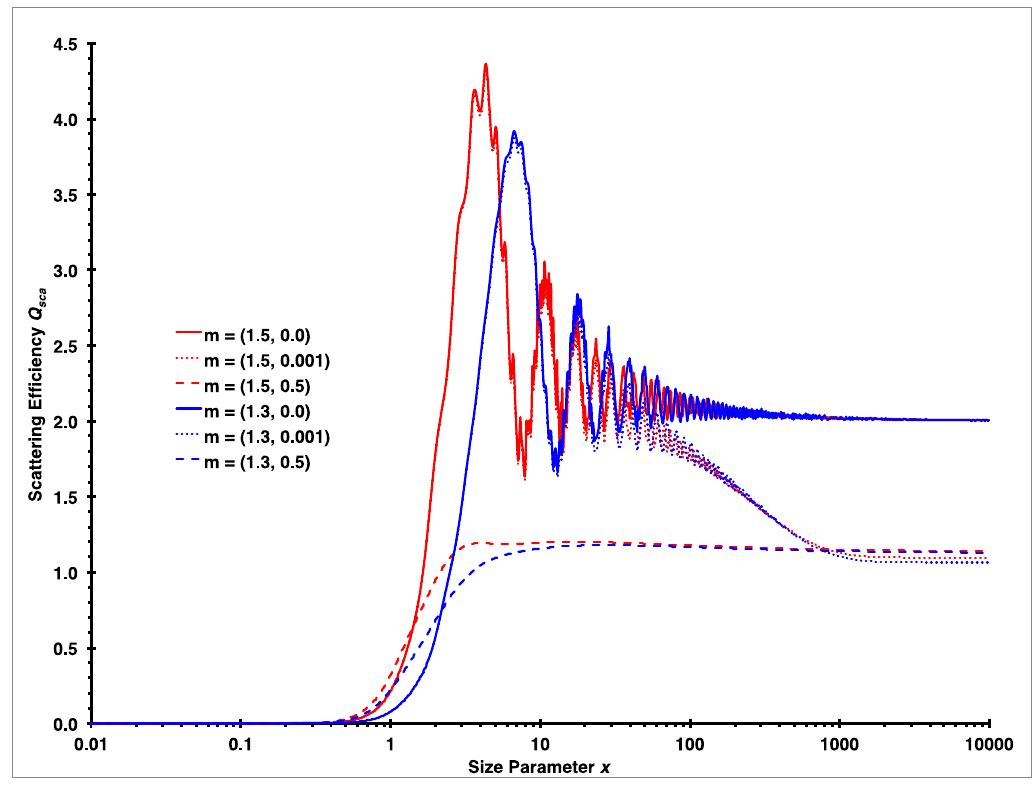
Figure 2. Mie theory scattering efficiency Q sca as function of size parameter x for all combinations of two real and three imaginary parts of the complex refractive indices m .